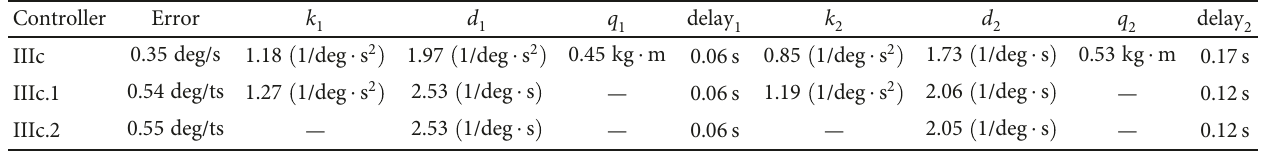
Figure 8: (a) The torques generated by the high gain PD: M hg time steps of the simulation on the x -axis. (b) Response of controller IIIc. The best fi t, with an remaining error of 0.16 deg/ts . First plot is the ankle trajectory, second is the hip, and third is the perturbation. Finally, the controller IIIc with torque coupling according to the numerical inertia tensor β realized the almost exact reproduction of the experiments. Table 2: Average parameter set X for controller IIIc on the training set S